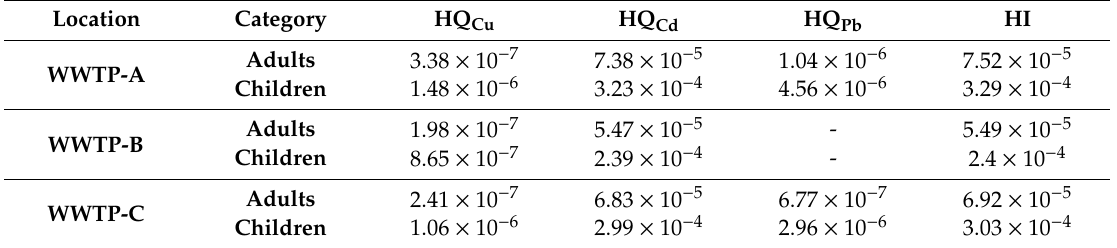
Table 5. Non-carcinogenic risk assessment by dermal contact in the sewage sludge.